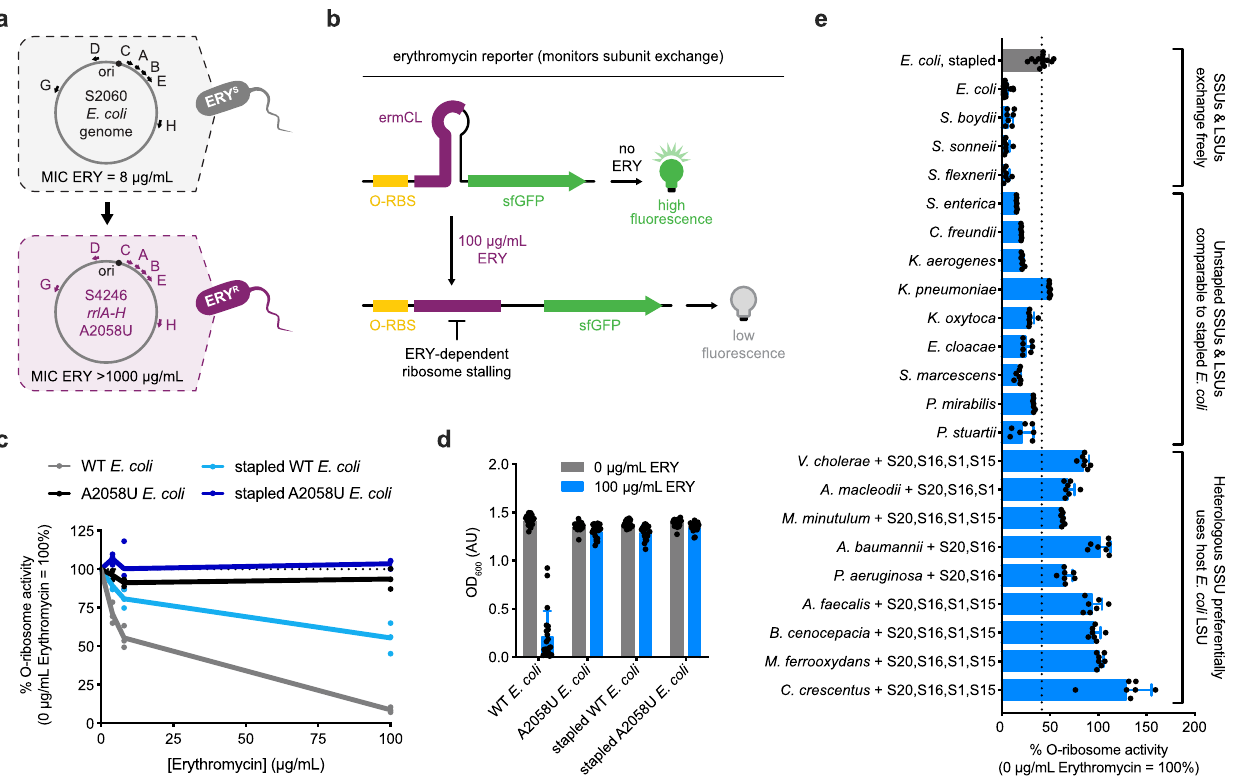
Fig. 6 The erythromycin-dependent orthogonal translation reporter system. a Creation of the erythromycin (ERY)-resistant E. coli strain S4246. All 7 rrl (A-H) 23S ribosomal RNA (rRNA) genes were mutated (A2058U) via oligonucleotide recombineering to endow high erythromycin resistance (ERY; MIC